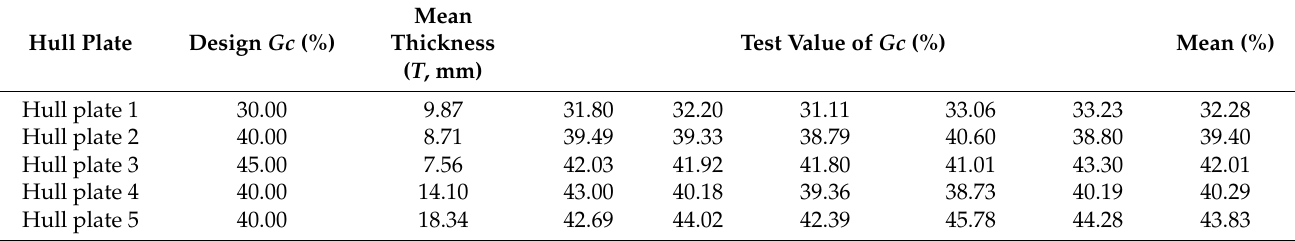
Table 6. Vv values of the hull plate specimens according to burn-off testing.